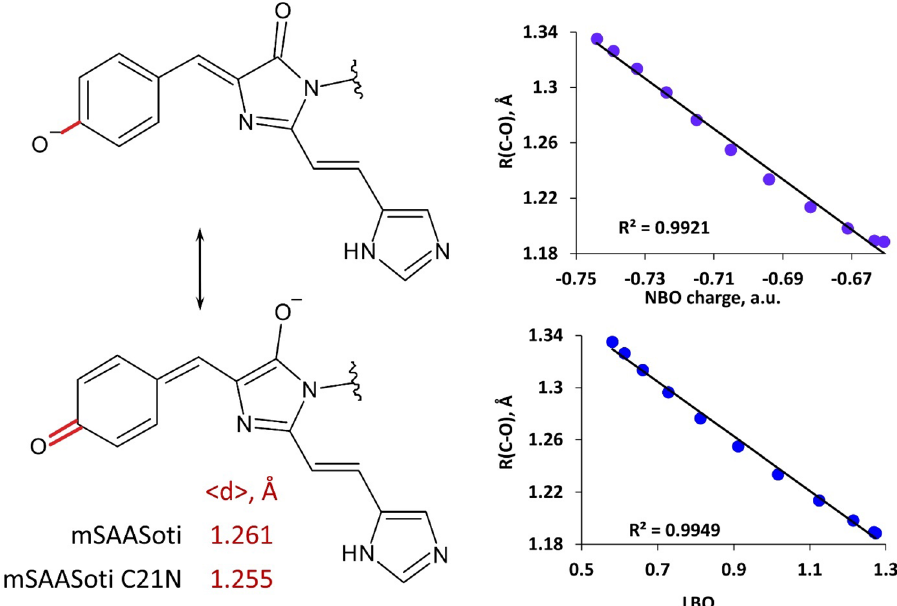
Figure 5. Two resonance forms of the anionic chromophore (left). The C–O bond of the phenyl fragment is shown in red. Its distance is longer (single bond) if the negative charge is located on the phenyl oxygen and shorter (double bond) if the negative charge is located on the imidazolinone oxygen. The mean distances, < d > , along the QM/MM MD trajectories are shown in the inset. Right panels demonstrate correlations between the electron density-based parameters, NBO charge (top) and LBO (Laplacian bond order, bottom), and the C–O bond